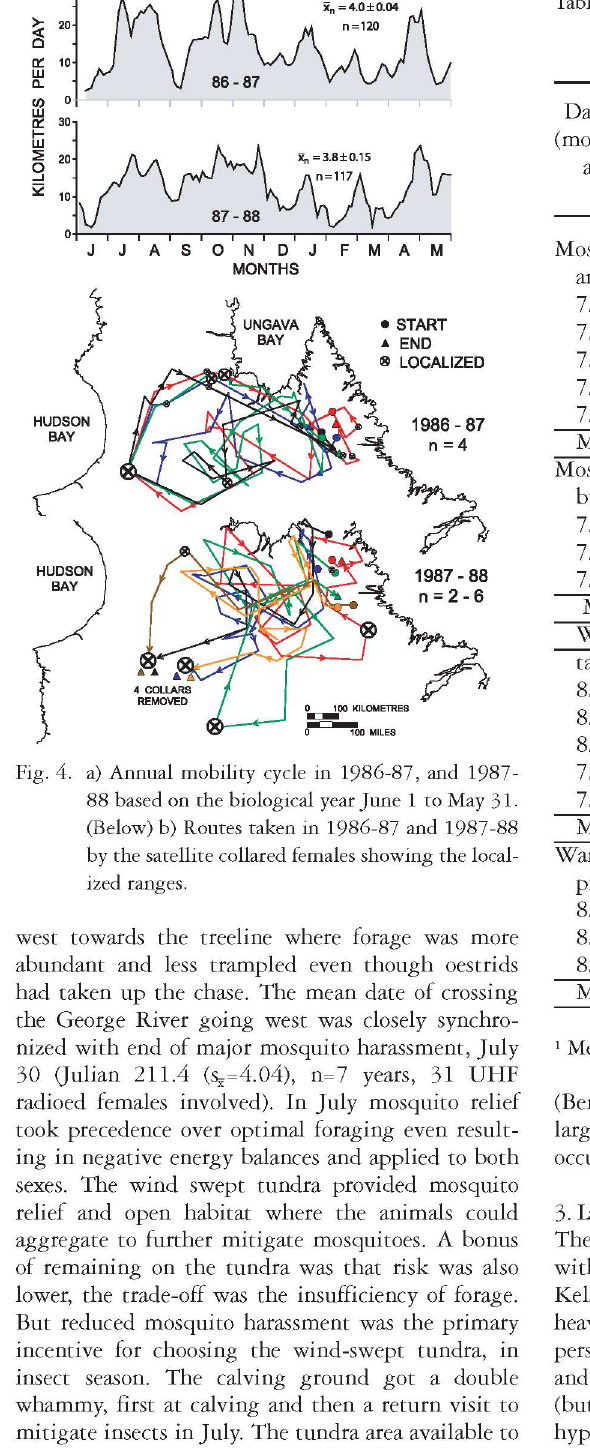
Table 4. Energy expenditures and intake